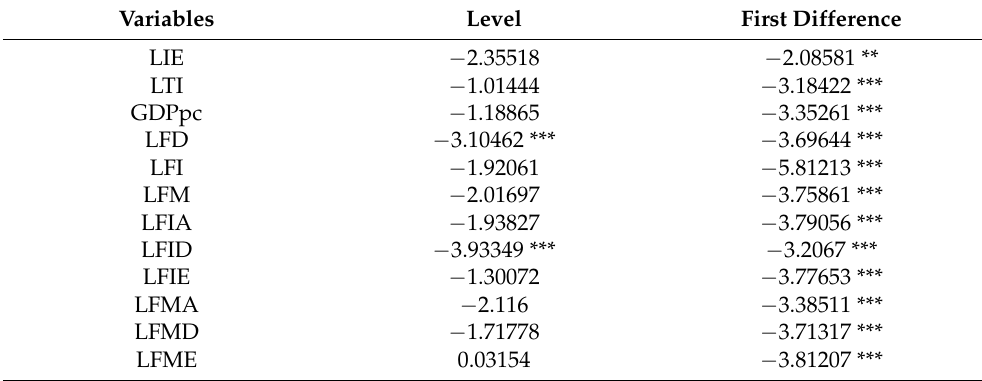
Table 3. Panel unit root test.